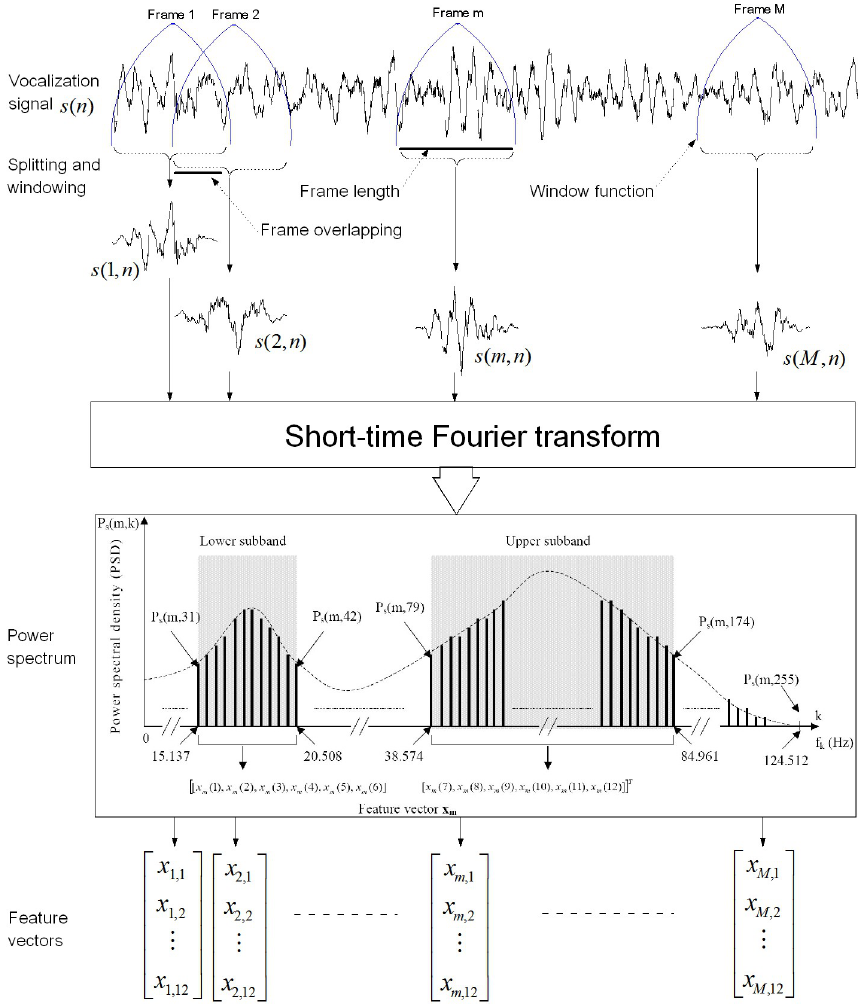
Figure 3. Feature extraction process based on the short-time Fourier transform (STFT). Power spectrum density P s ( m , k ) of each signal frame s ( m , k ) is computed using the STFT. The feature vector x m is constructed by extracting six components from lower subband (15.1375–20.508 Hz) and six components from upper subband (38.574–84.961 Hz). The discrete frequencies are obtained with a sampling frequency of 250 Hz and a frame length of 512